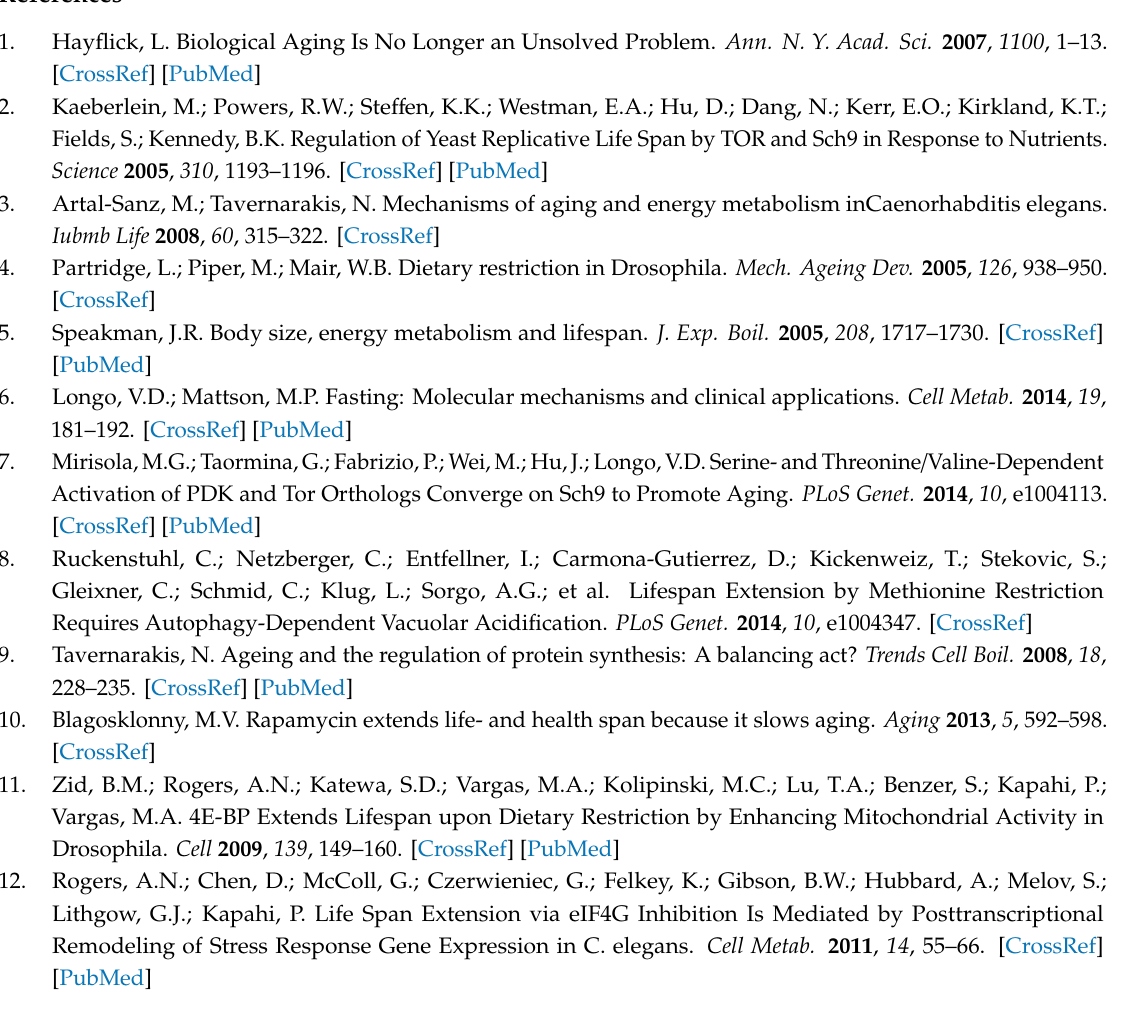
Table S1: Cellular component of Gene Ontology (GO) enrichment analysis. GO cellular component includes number of cellular components of upregulated and downregulated genes (Sheet 1). Relative level of mRNA uL11A and uL11B in BY4741 wild-type strain (Sheet